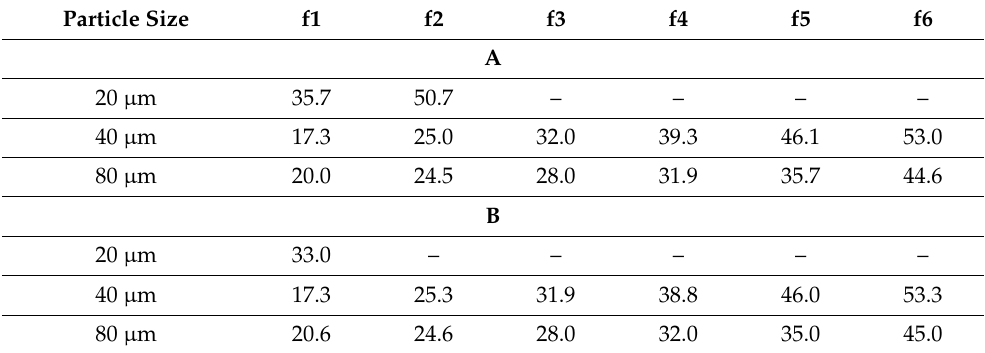
Table 2. (A) Predicted eigenfrequencies (in MHz) for different particle sizes based on simulations. (B) Experimentally obtained eigenfrequencies (in MHz) for different particle